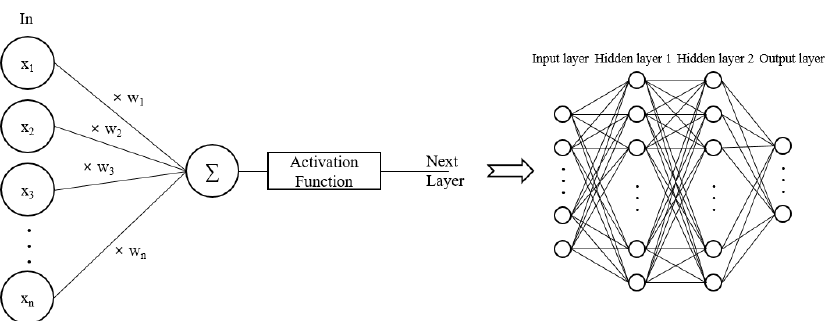
Figure 3. Neurons in neural network models and a multilayer perceptron (MLP)